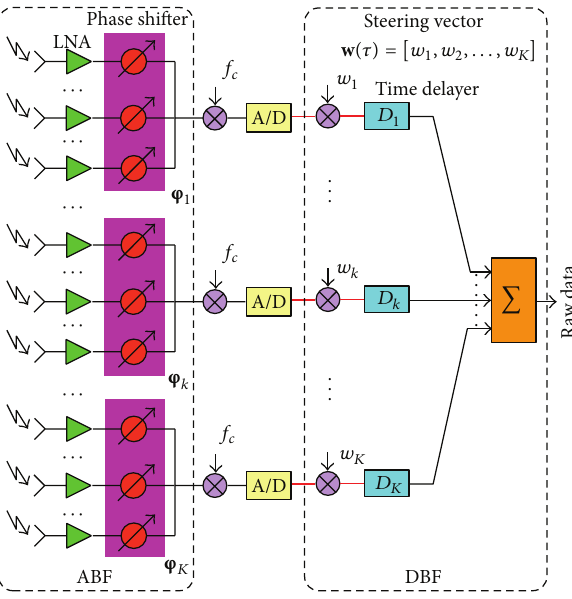
Figure 3: The block diagram of ABF and DBF on receive in eleva- tion.